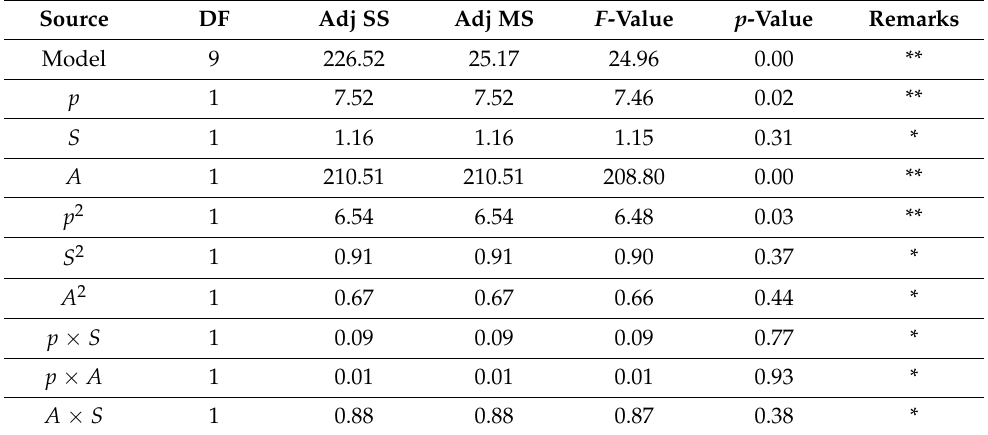
Table 3. Analysis of variance (ANOVA) of the model for the EPS